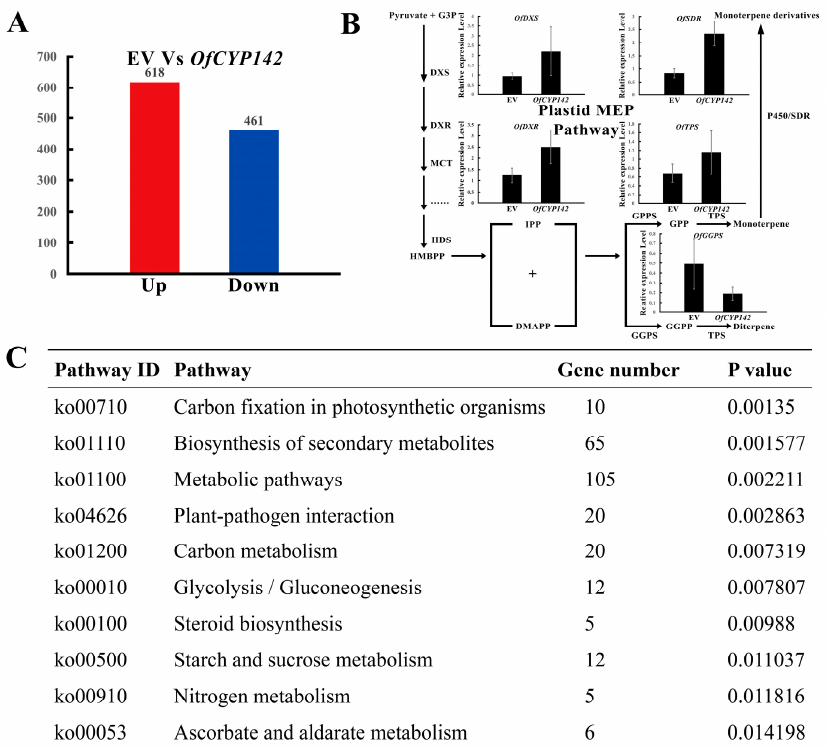
Figure 8. Transcriptome profiling of transgenic flowers. ( A ) Number of DEGs in transgenic flowers. ( B ) The MEP pathway responsible for the formation of terpenes in plants, and qRT-PCR validation of expression patterns of candidate genes in the MEP pathway. Relative expression levels of the selected genes were analyzed by qRT-RCR using OfRAN as an internal control. ( C ) Information of top 10 enriched KEGG terms according to p -value.